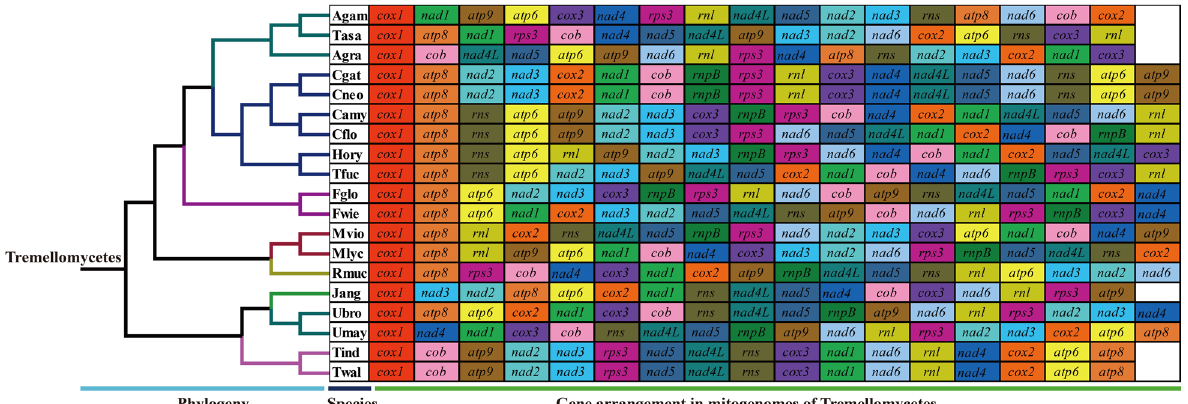
Fig. 7 Mitochondrial gene arrangement analyses of the 19 mitogenomes from Agaricomycotina, Pucciniomycotina and Ustilaginomycotina . The same gene were represented by same color blocks. Phylogenetic positions of the 19 species were established using the Bayesian inference (BI) method and Maximum Likelihood (ML) method based on combined mitochondrial data sets. Species information is shown in Additional file